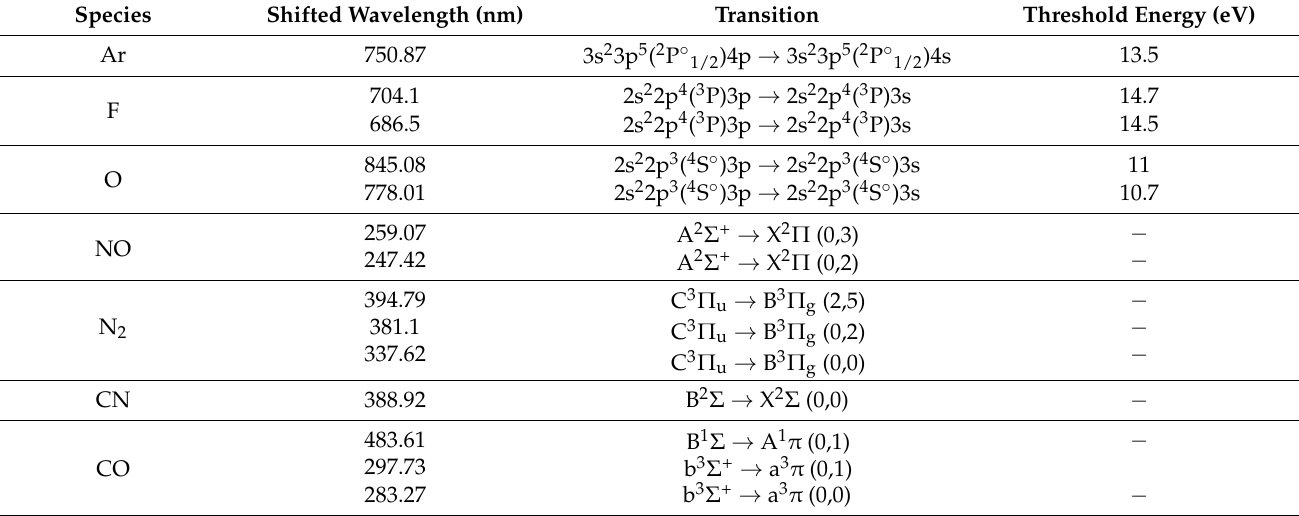
Table 3. Information on selected wavelengths used in